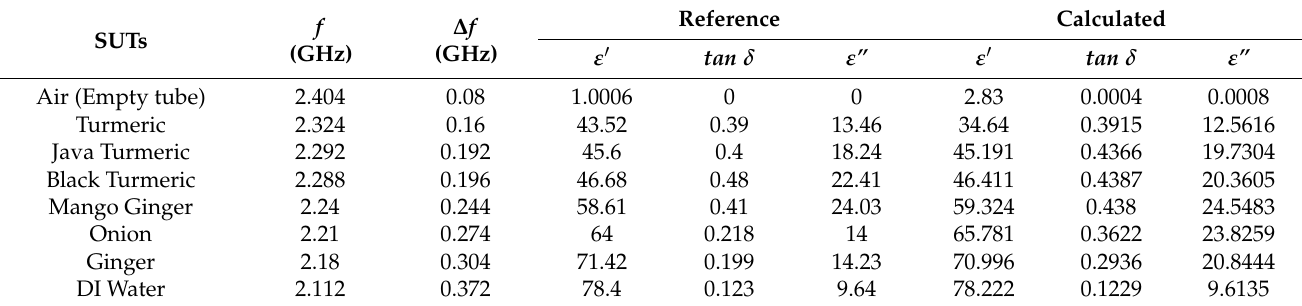
Table 9. The calculated complex permittivity of several known and unknown SUTs (semi-solid).